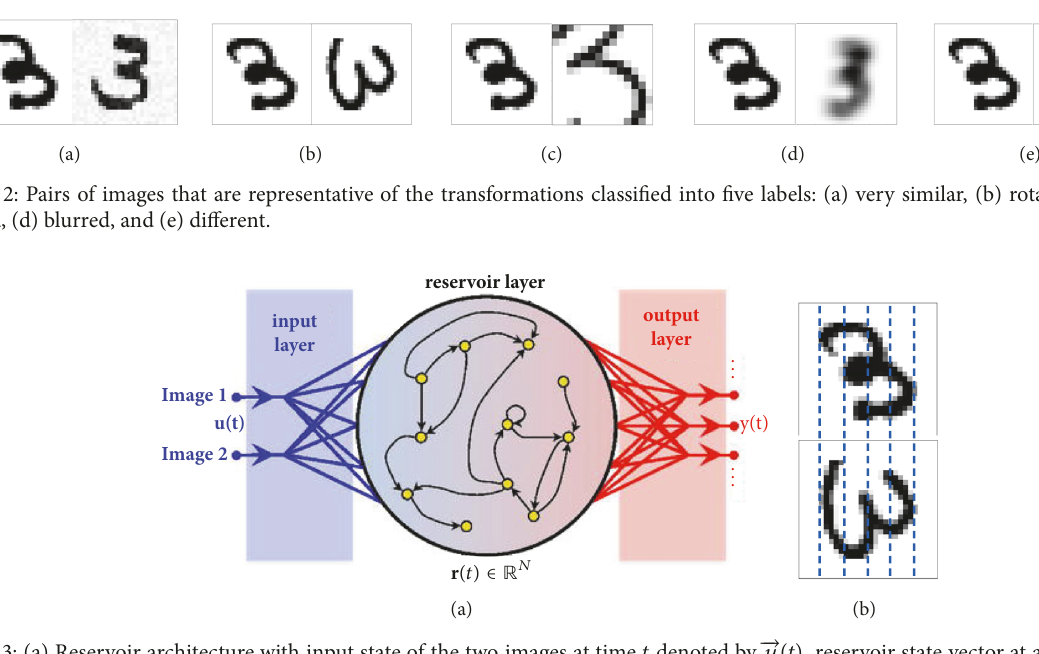
Figure 3: (a) Reservoir architecture with input state of the two images at time 𝑡 denoted by 󳨀→ 𝑟 (𝑡) 󳨀→ 𝑦 , and output state by . (b) shows one image pair from the rotated 90 ∘ category of the MNIST dataset split vertically and fed into the reservoir in columns of 1 pixel width, shown to be larger here for ease of